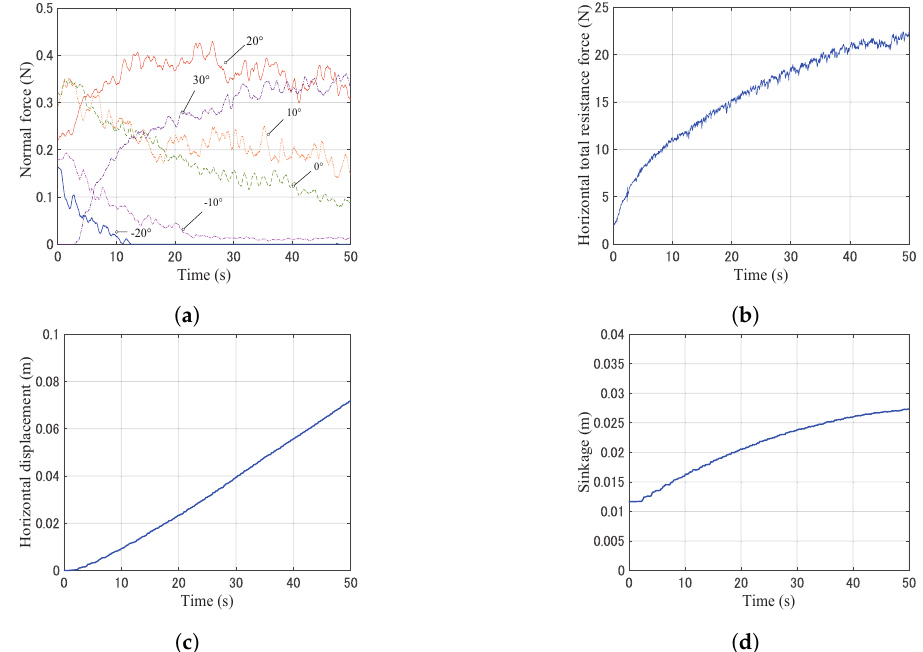
Figure 13. Raw data over time. ( a ) Typical raw data of normal force values at the contact area from − 20 ◦ to 30 ◦ (Case B). ( b ) Total resistance force over time. The data were measured by the separate force sensor installed above the wheel unit (Figure 9). ( c ) Horizontal displacement over time. The data were measured by a motion-capture system. ( d ) Sinkage over time. The data were measured by a motion-capture